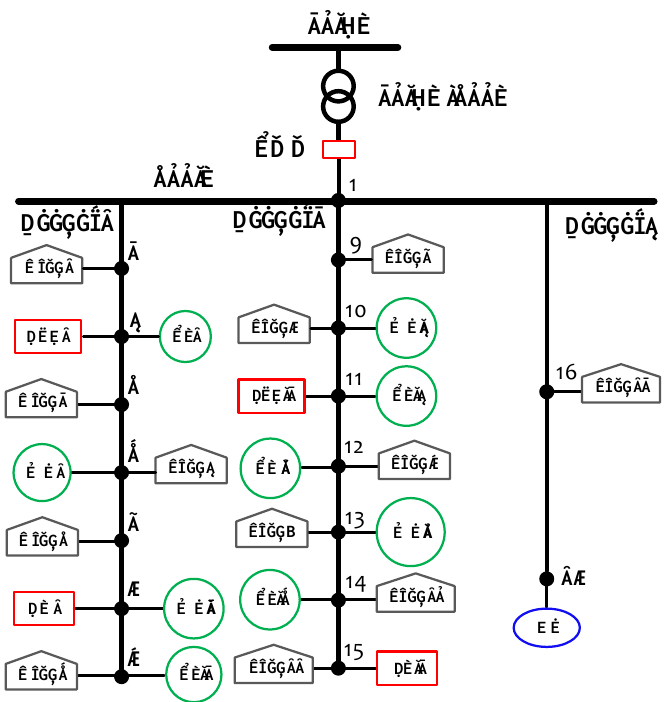
Figure 4. Single-line diagram of the microgrid test system.